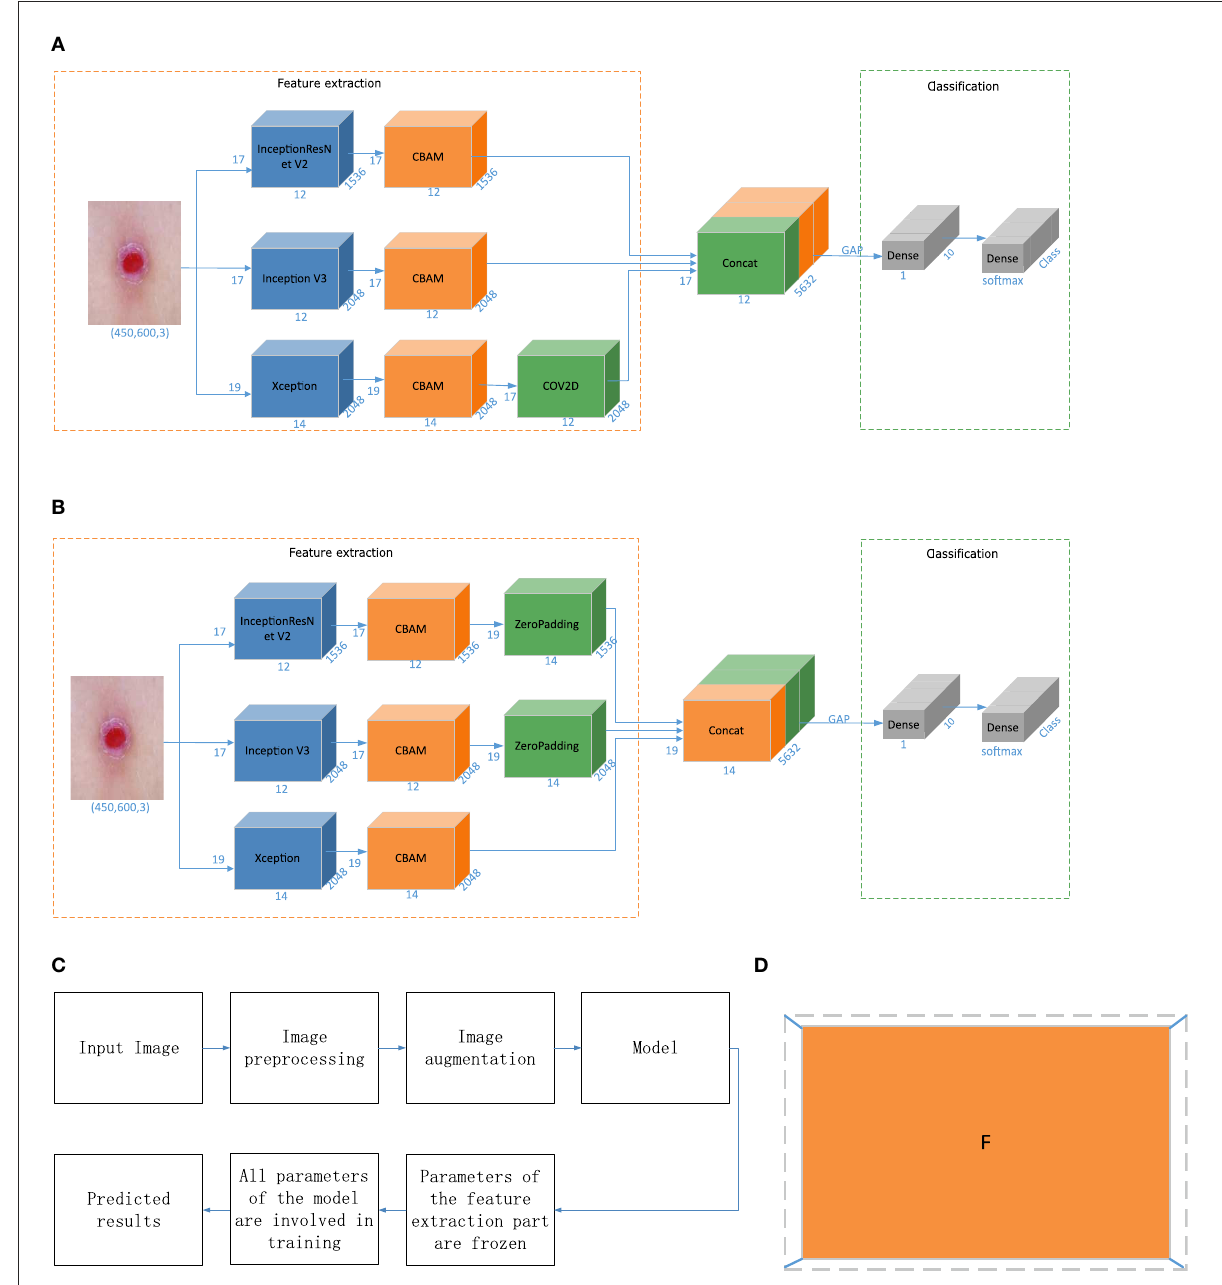
FIGURE4 Model building and prediction. (A) Fusion based on the convolution operation. (B) Fusion based on the padding operation. (C) Model training process. (D) Zero-padding operation. “CBAM” is the attention mechanism, “zero padding” involves filling a circle of 0 s around the height and width of the feature vector, “Concat” denotes feature fusion, “GAP” is a global average pooling layer, “Dense” is a fully connected layer, “COV2D” is a convolution operation, and “Class” is the number of categories. In this article, Class is 7. “Softmax” is the activation function of the classification output layer, and the number represents the change in the dimensions in each